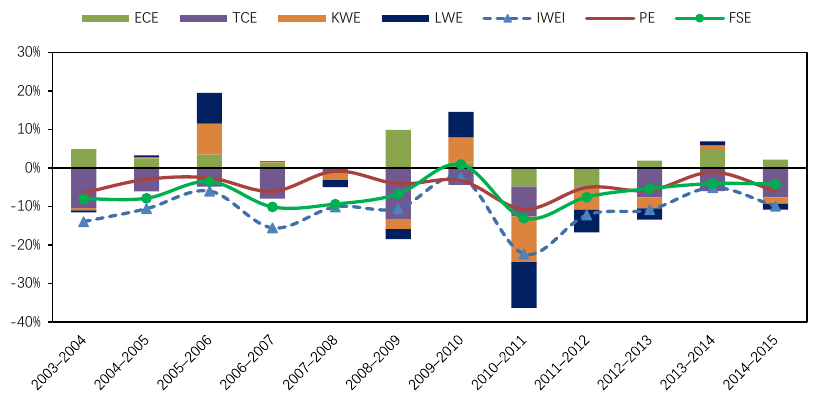
Figure A5. Driving factors of industrial wastewater emission intensity change in the Middle Reaches of the Yellow River, 2003 – 2015. ECE: the effect of technical efficiency change; TCE: the effect of technological change; KWE: the effect of capital – wastewater substitution; LWE: the effect of labor – wastewater substitution; IWEI: industrial wastewater emission intensity; PE: productivity effect; FSE: factor substitution effect. Int. J. Environ. Res. Public Health 2018 , 15 , x 21 of 25